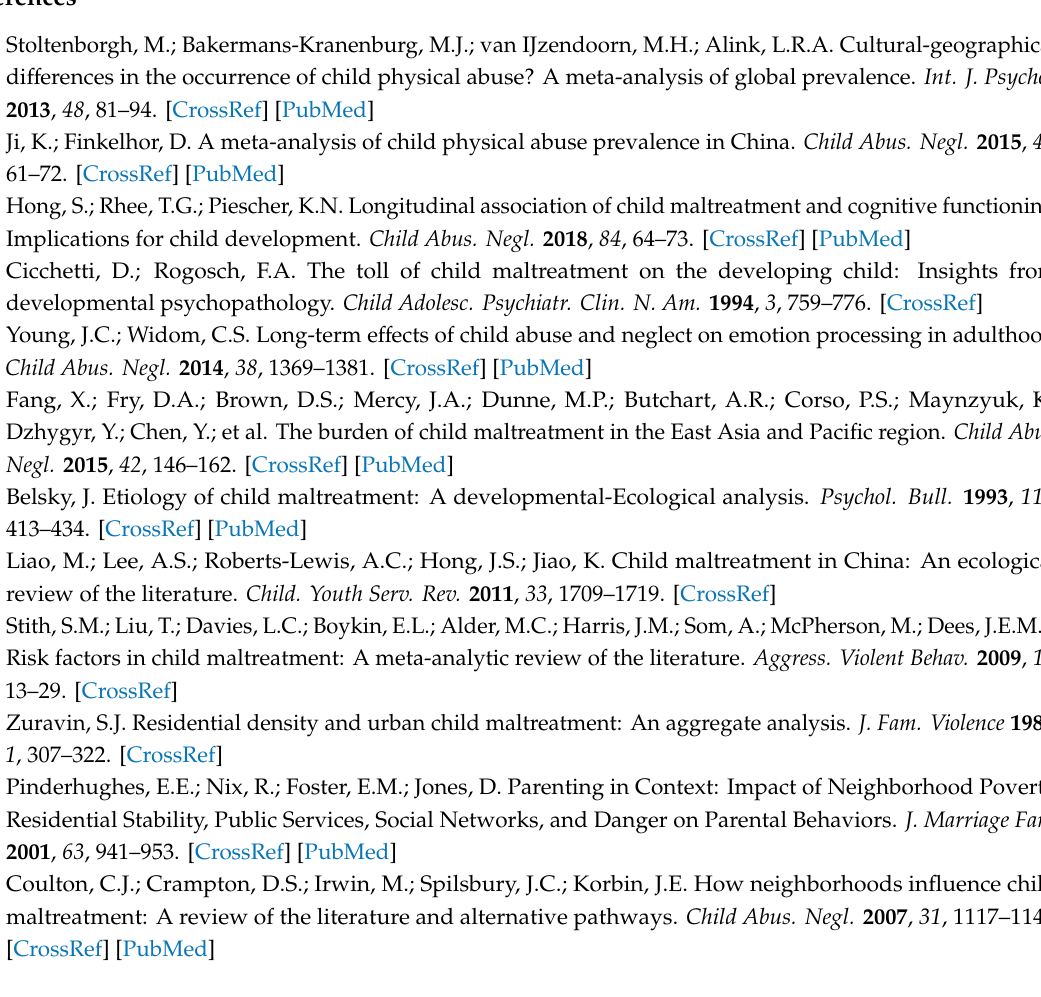
Table S1: Results of the reliability analysis; Table S2: Results of the validity